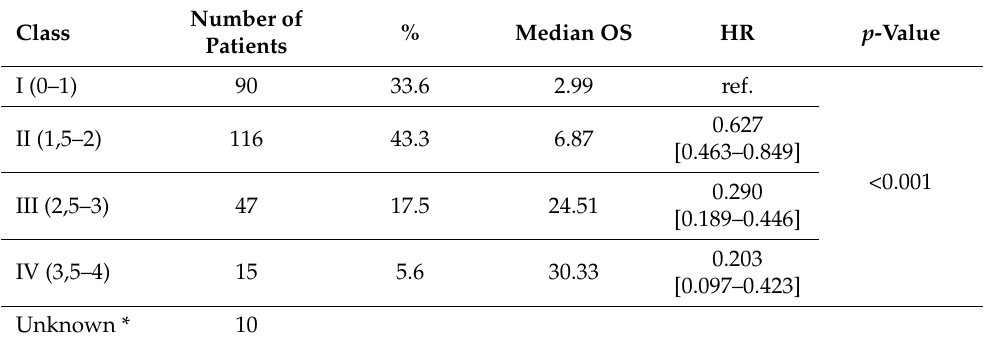
Table A6. Median overall survival of the melanoma-molGPA classes of patients with melanoma brain